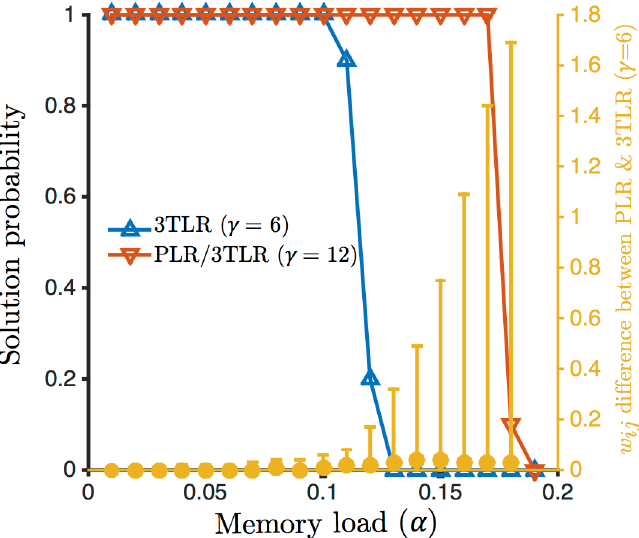
Fig 10. Direct comparions of the 3TLR and the PLR. Success probability for the 3TLR at γ = 6 (blue curve, left axis) and the PLR (red curve) at f=0.5 and ϵ =3; the results for the 3TLR at γ = 12 are identical to those of the PLR (red curve). The orange points show the absolute difference of weights between the final values of the weights for the PLR at γ = 6 and the PLR (right axis): the points show the median of the distribution, while the error bars span the 5th-95th percentiles, showing that, while the distribution is concentrated at near-zero values, outliers appear at the critical capacity of the 3TLR algorithm. (Note that the average value of the weights is in all cases approximately 1.08; also compare the discrepancies with the overall distribution of the weights, Fig